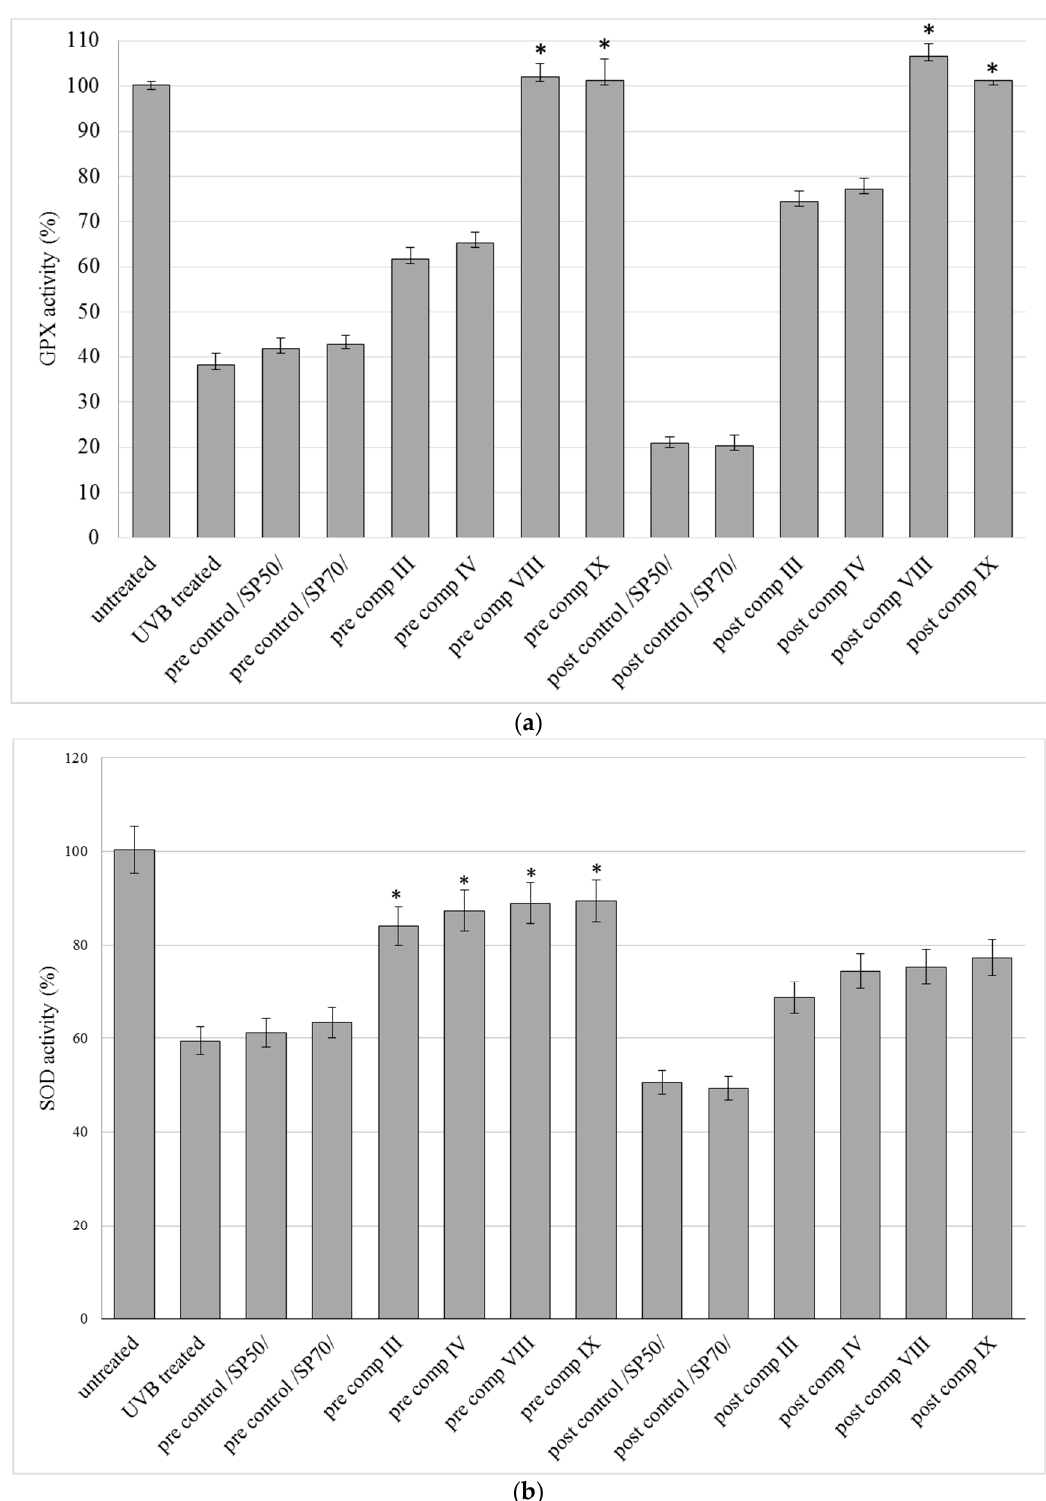
Figure 5. Cont . Figure 5.